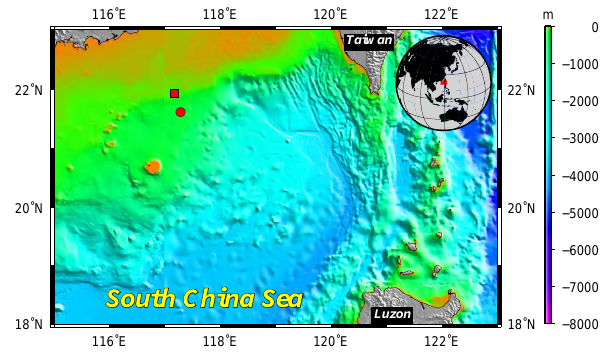
Fig. 1. The mooring location (shown as a red dot) on the continental slope of the northern South China Sea. The local water depth was 350m. The square marks the location of the density profile in Fig.